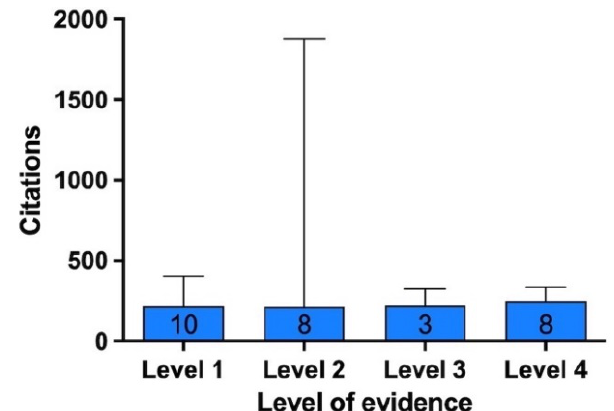
Figure 8. Median and maximum citation per article based on level of evidence. A bar graph showing